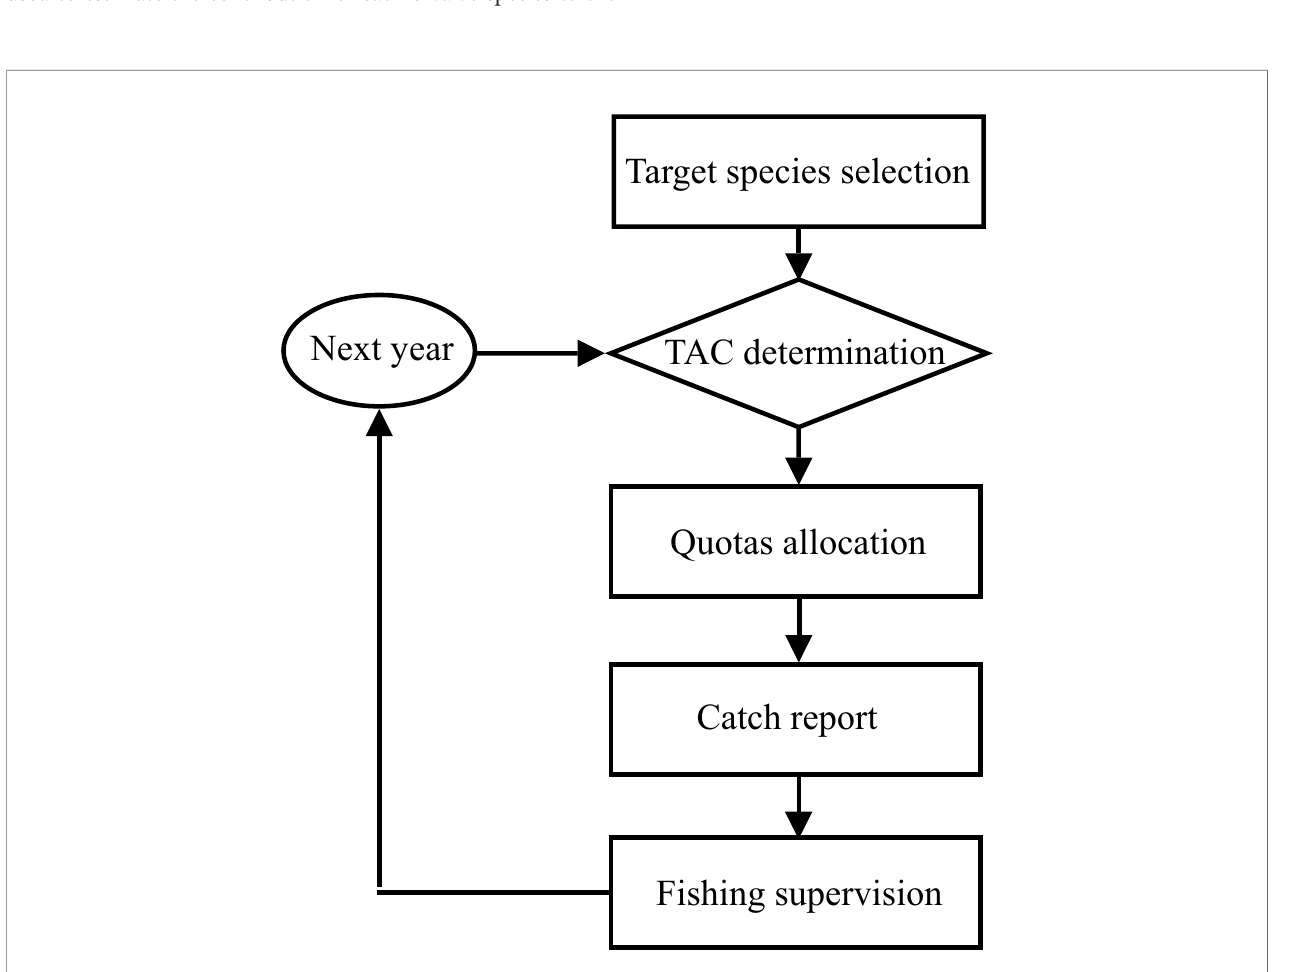
FIGURE 1 | The conceptual framework of the fi shing quota